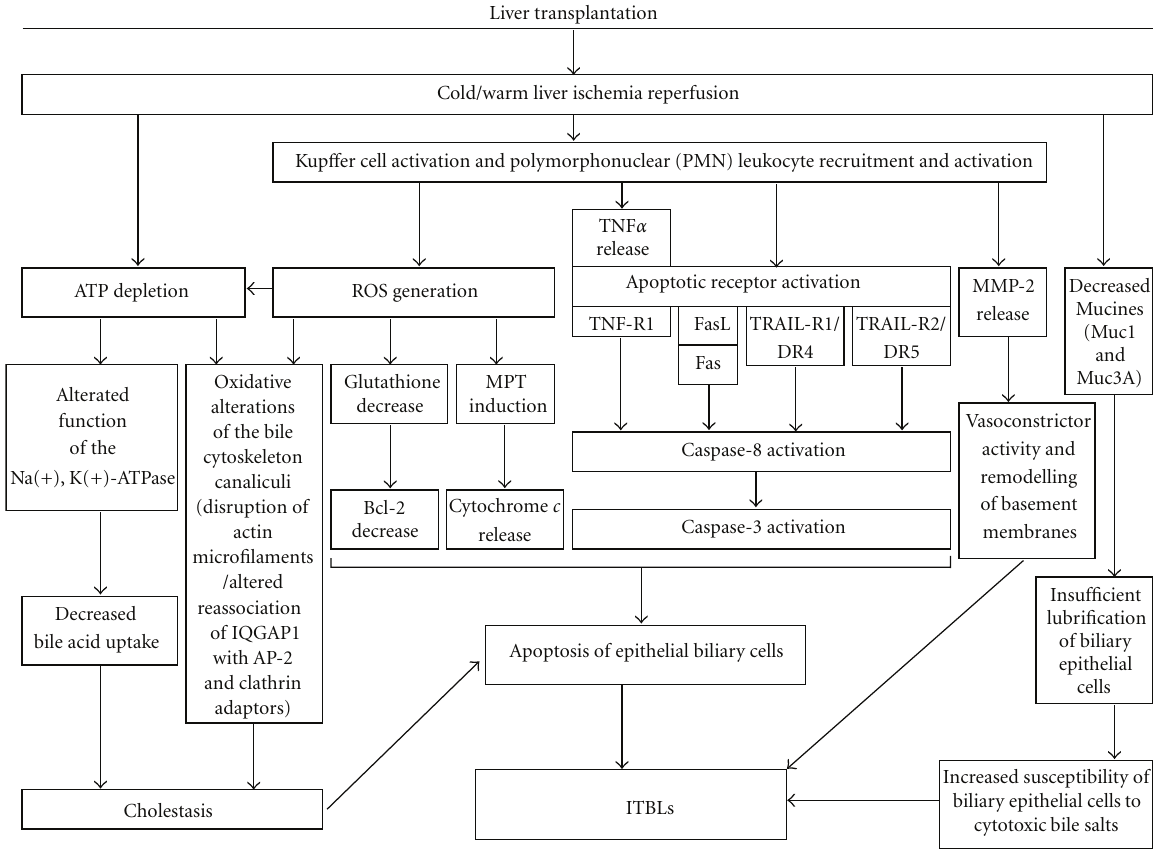
Figure 2: Role of Kup ff er cells and PMNs in cold and warm ischemia leading to the development of ITBLs following LT. The epithelial lining of the biliary tree is exposed not only to proinflammatory mediators derived from extrahepatic sources, via arterial circulation, but also to proinflammatory mediators derived from intrahepatic sources, such as inflammatory cells or Kup ff er cells. These inflammatory mediators promote the invasion of PMNs into the interstitium. PMNs then penetrate the ductal basal membrane and contribute to bile duct injury. Thus the main event injury seems to be activation of Kup ff er cells and recruitment and activation of PMNs leading to apoptosis of epithelial biliary cells. PMN: polymorphonuclear neutrophils; ROS: reactive oxygen species; ATP: adenosine triphosphate; Na(+), K(+)- ATPase: sodium pump; TNF α : tumor necrosis factor alpha; TNF-R1: tumor necrosis factor receptor 1; MPT: mitochondrial permeability transition; Bcl-2: B-cell CLL/lymphoma 2 protein; IQGAP1: regulator molecule of bile canaliculi structure; AP-2: endocytic multimeric adaptor; Clathrin: endocytic monomeric adaptors; FasL: Fas ligand; TRAIL-R1/DR4: tumor necrosis factor-related